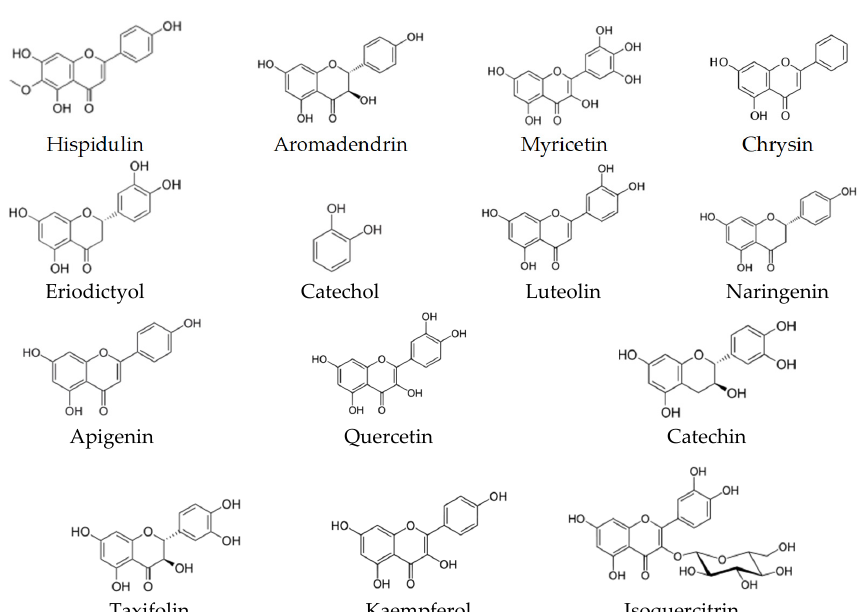
Figure 6. Flavonoids have been reported in different types of SBH.